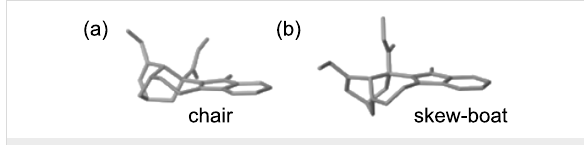
Figure 5: Stable conformers of